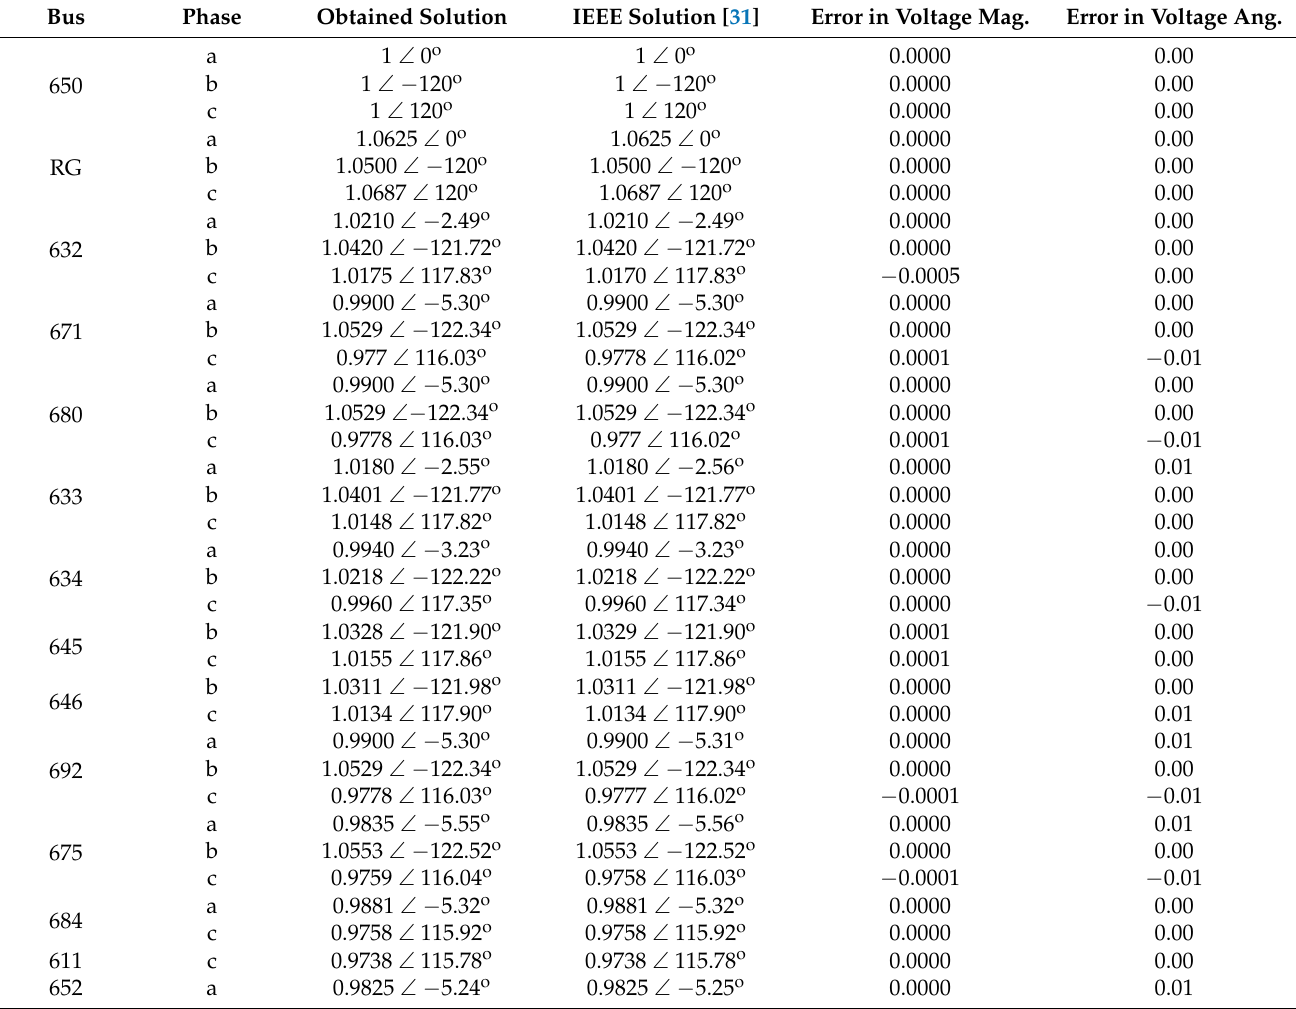
Figure 7. IEEE 13 Bus URDN. Table 4. Fundamental voltage solution for IEEE − 13 bus